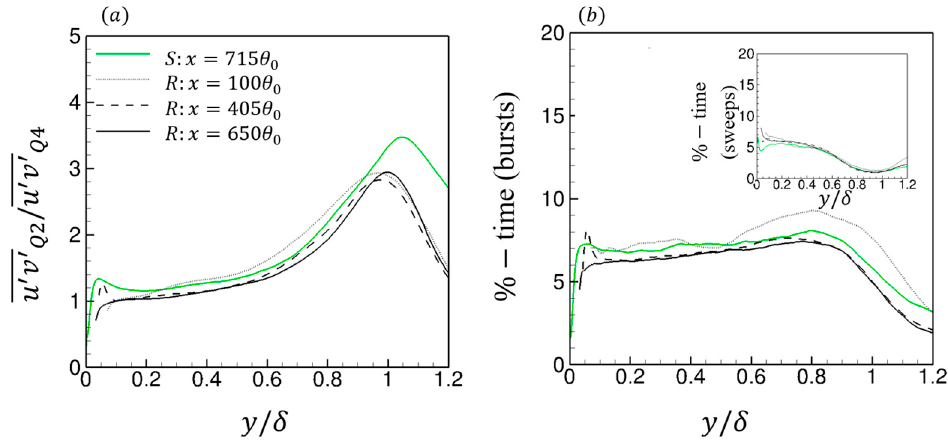
Figure 16. ( a ) Ratio of contribution to the turbulence shear stress by 𝑄2 to 𝑄4 . ( b ) Percentage of total time spent as bursts (inset: percentage of total time spent as sweeps). The lines in ( b ) follow the labels from ( a ). Profiles for case 𝑅 are only presented for the wall-normal extent above the canopy.